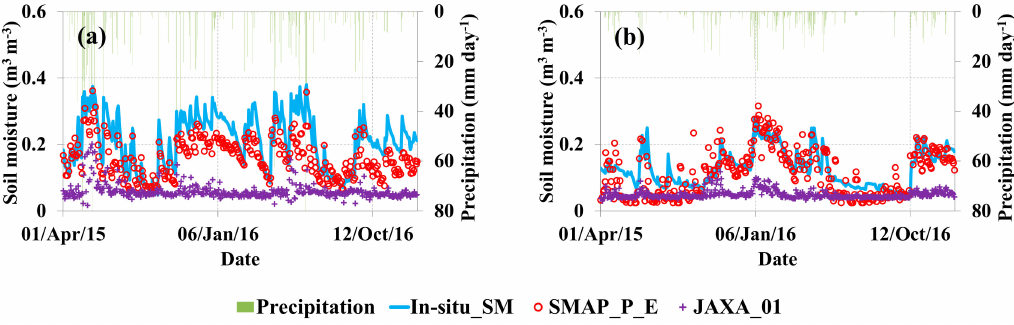
Figure 3. Temporal evolution of the station-averaged soil moisture and satellite soil moisture with a spatial resolution of 0.25 ◦ for the ( a ) LWW and ( b ) REMEDHUS networks. Soil moisture products are divided into the vertically-oriented panels in ( a , b ) for visualization purposes.